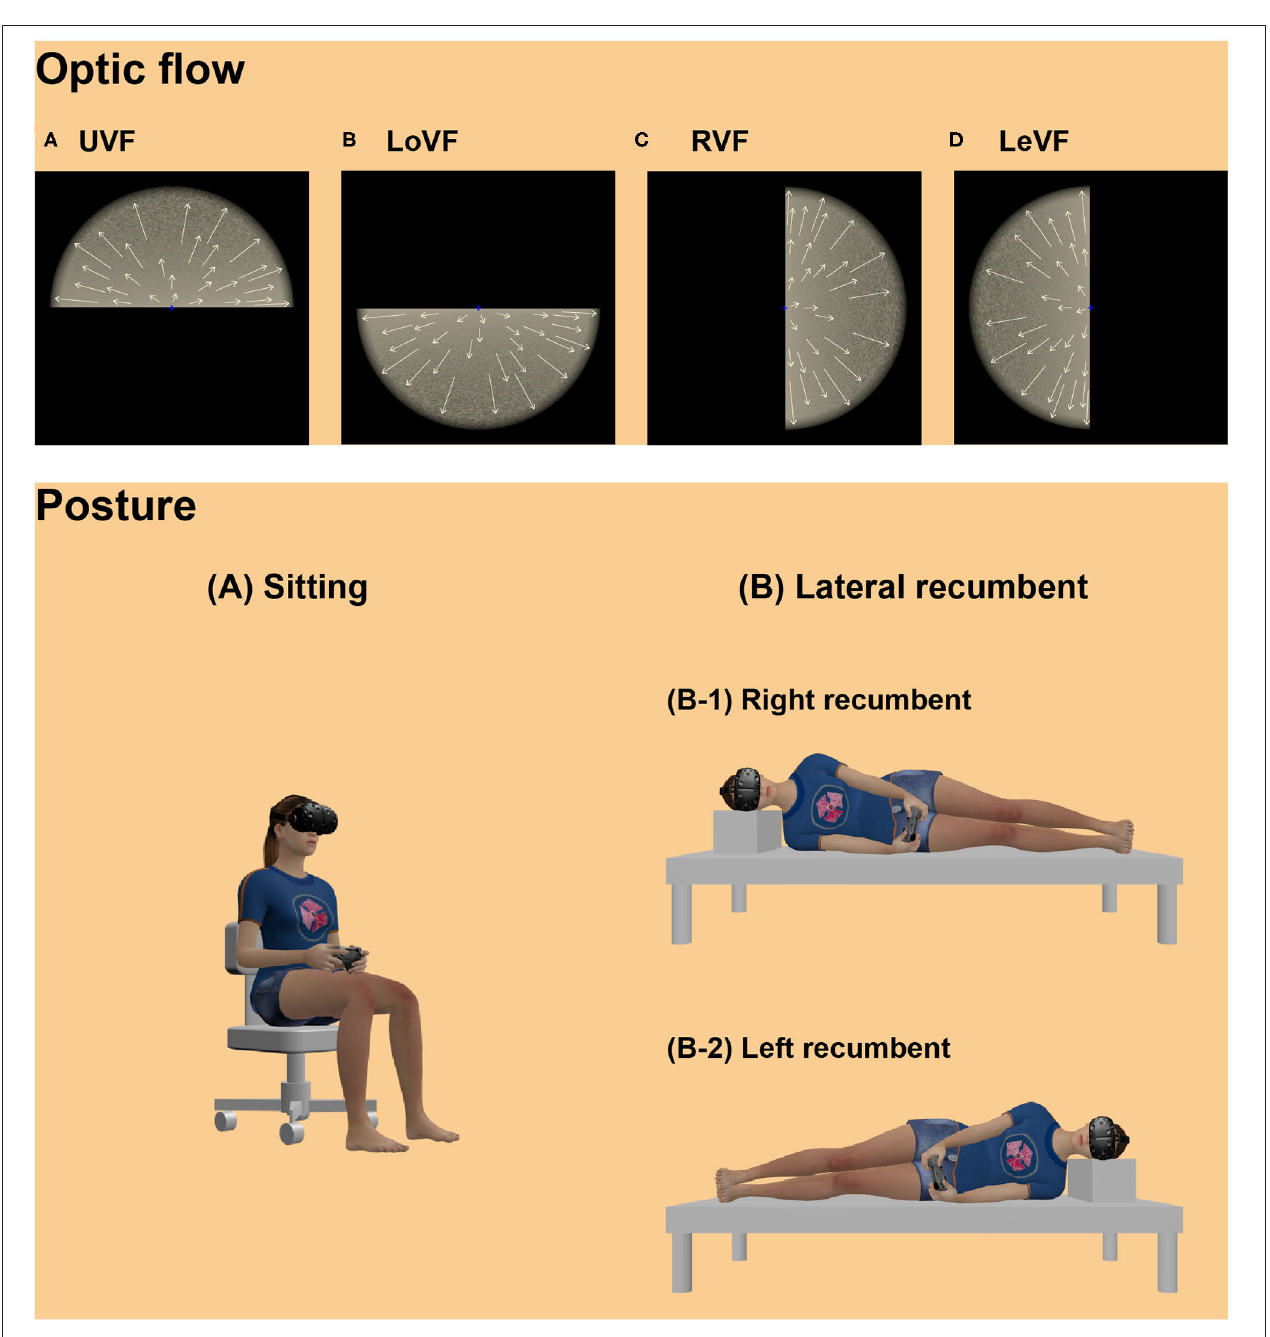
FIGURE 1 | Illustrations of optic flow displays (upper panel) and postural conditions (lower panel) in the VR scene. Illustrations in the upper panel indicate optic flow stimuli presented in the (A) UVF, (B) LoVF, (C) RVF, (D) LeVF, moving radially. Arrows on the optic flows illustrate motion vectors. Note that the visual fields were defined based on the egocentric axis of the participants. Participants observed the optic flow stimulus while (A) sitting upright or (B) lying down on their side: half of the participants lay right side down (right recumbent: B-1 ), and the other half lay left side down (left recumbent: B-2 ). Licensed 3d models: “HTC Vive” © Eternal Realm, available at https://sketchfab.com/3d-models/xbox-one-controller-free-97fb54c001f84a6896b6ce8eb7a1814d; “Xbox One Controller Free” © paxillop, available at https://sketchfab.com/3d-models/htc-vive-4818cdb261714a70a08991a3d4ed3749 (all licensed under CC BY 4.0).